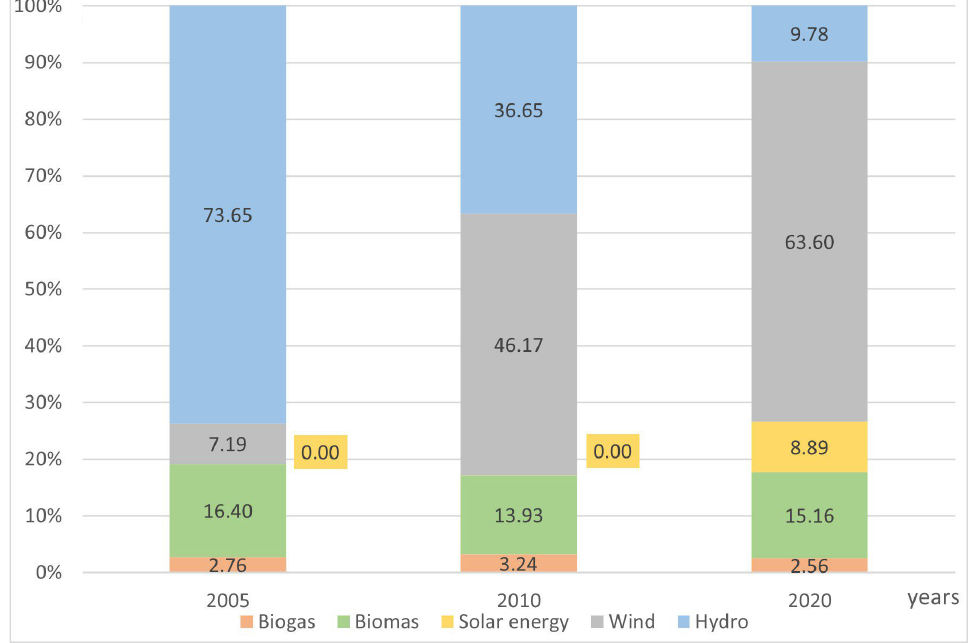
Figure 8. Change in the structure of installed capacity by type of RES in Poland in the years 2005–2020 in (%). Source: Renewable Energy Resources. Statistical Yearbook, SP.